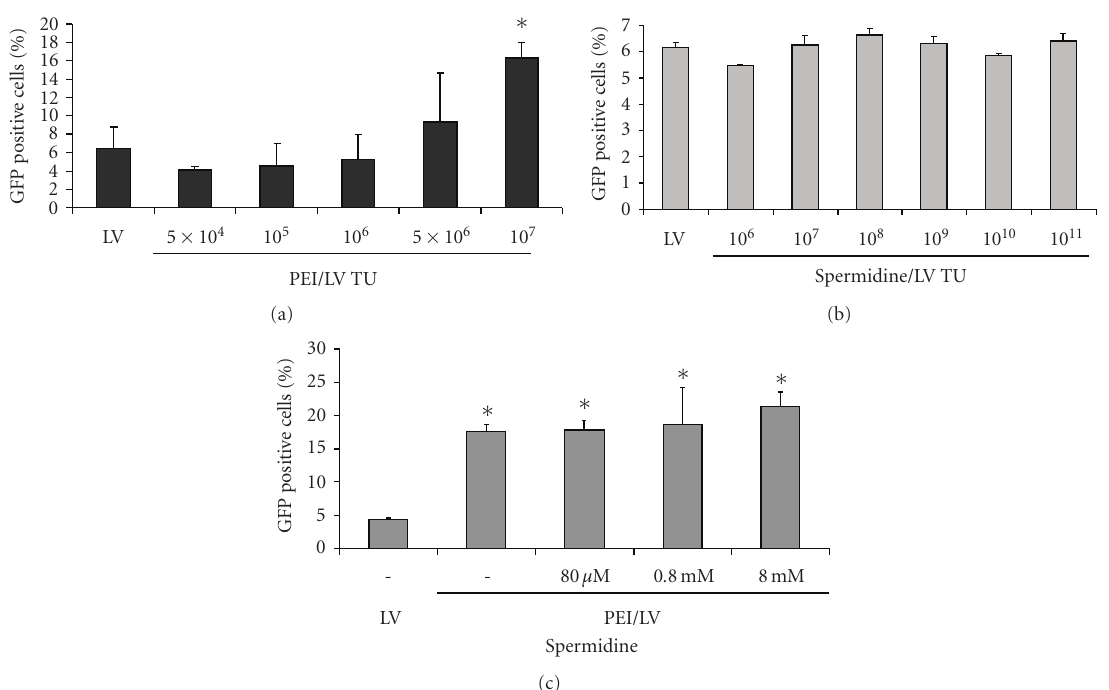
Figure 4: E ffi ciency and e ff ect on membrane permeability of PEI/LV vectors . Polarized 16HBE41o- cells were incubated with LV (50 MOI) either alone, formulated at di ff erent PEI molecules/TU ratios (A), or at di ff erent spermidine molecules/TU ratios (B) for 24 hours and then further incubated for 48 hours and evaluated for GFP expression. In another experimental setting, cells were pre-incubated with spermidine (range 0.08–8 mM) prior to addition of PEI/LV vector formulated at 1 × 10 7 ratio with 50 MOI LV (C). Note that PEI/LV increased the transduction e ffi ciency by 3.6 fold as compared to plain LV. Data are expressed as means ± SD of two-three experiments. A: ∗ P < . 05 for 10 7 PEI/LV TU versus all the other conditions except 5 × 10 6 . C: ∗ P < . 05 for all the conditions versus LV alone.